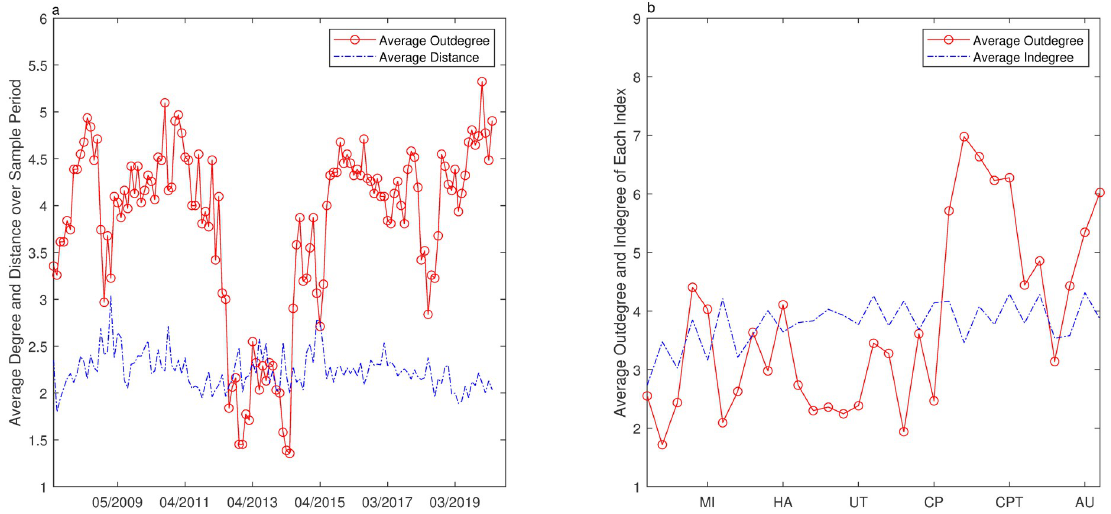
Fig 6. Network topology of industry index over rolling windows. a Shows distributions of outdegree and indegree over different periods. b Shows outdegree and indegree for different indexes during the whole period.